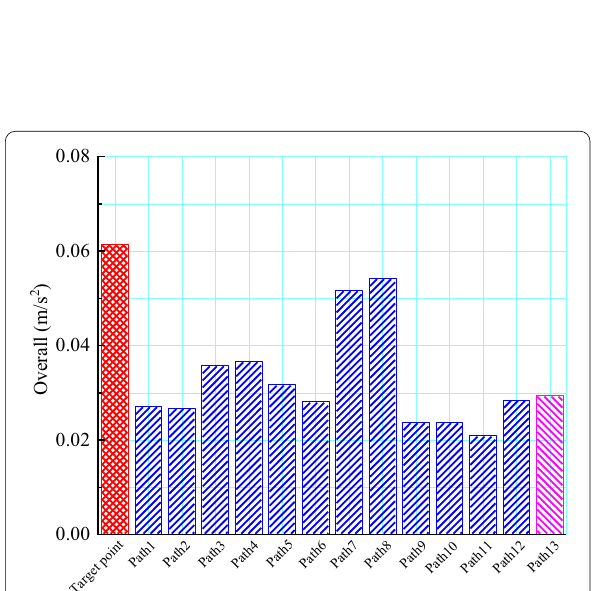
Figure 10 Overall value of the transfer paths’ contributions; path definitions are listed in Table 3